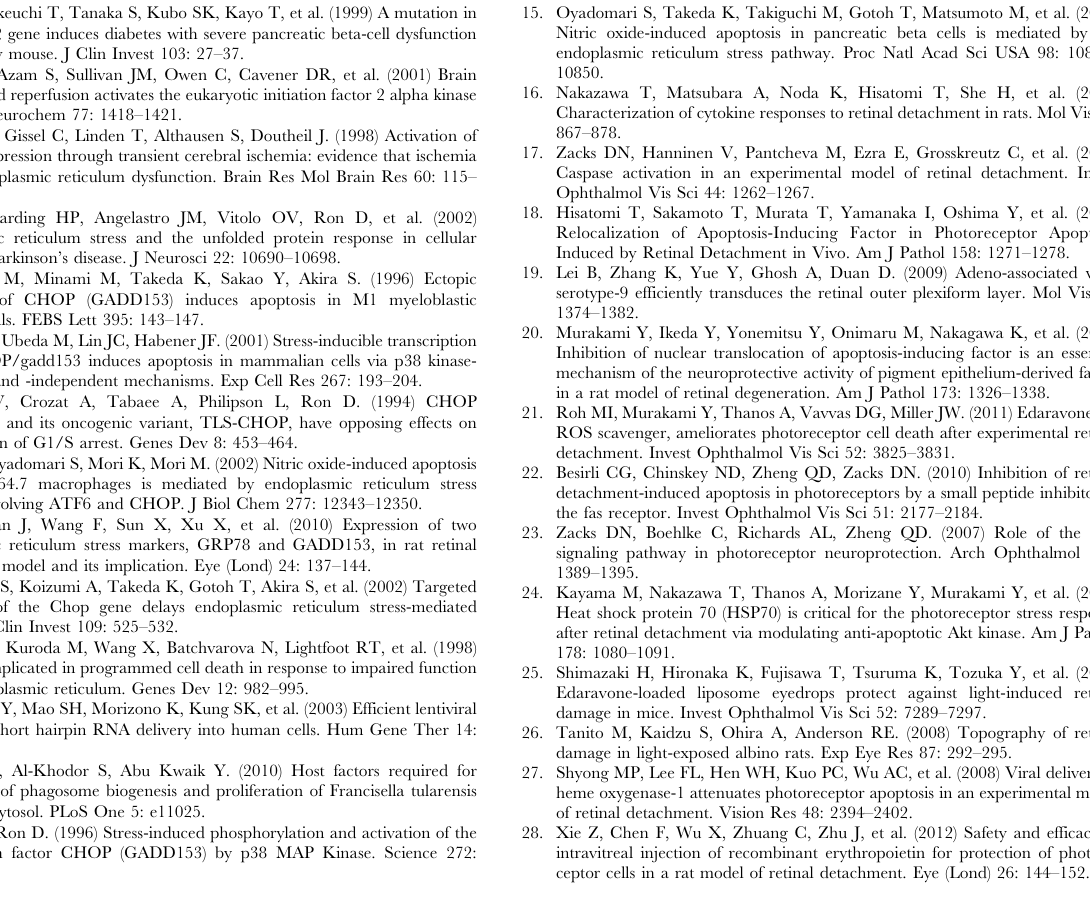
Figure S2 Delivery efficiency of lentivirus GADD153 shRNA-1 in vitro under fluorescence microscope. Expres- sion of GFP was firstly observed 1 week after the injection of lentivirus GADD153 shRNA-1 (A), peaked at 2 weeks (B) in retina frozen sections. Table S1 Three alternative sequences of GADD153 shRNA and the control construction. All the alternative sequences of GADD153 shRNA and the control construction are